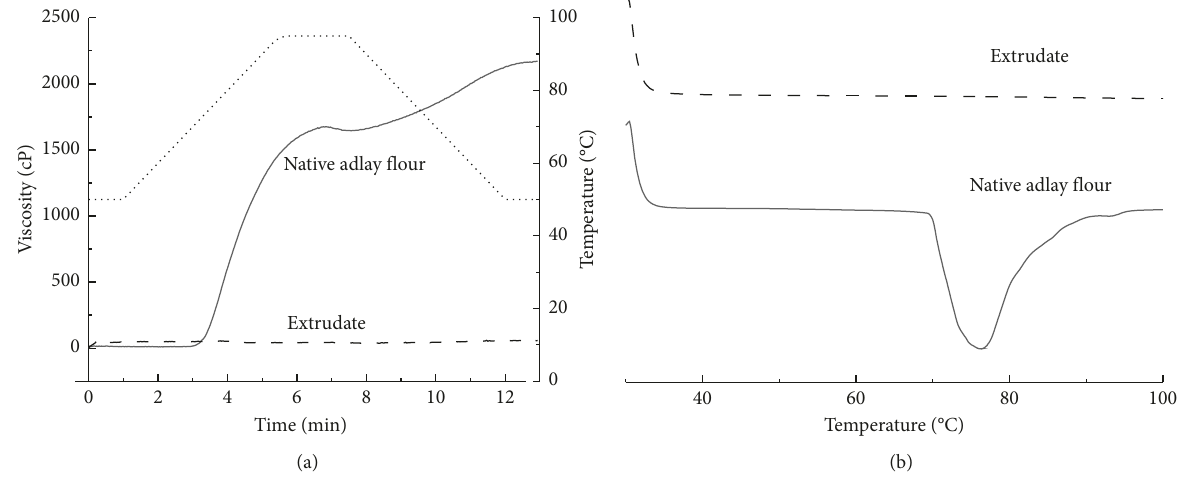
Figure 3: RVA curves (a) and thermal properties (b) of native adlay flour and adlay flour treated by